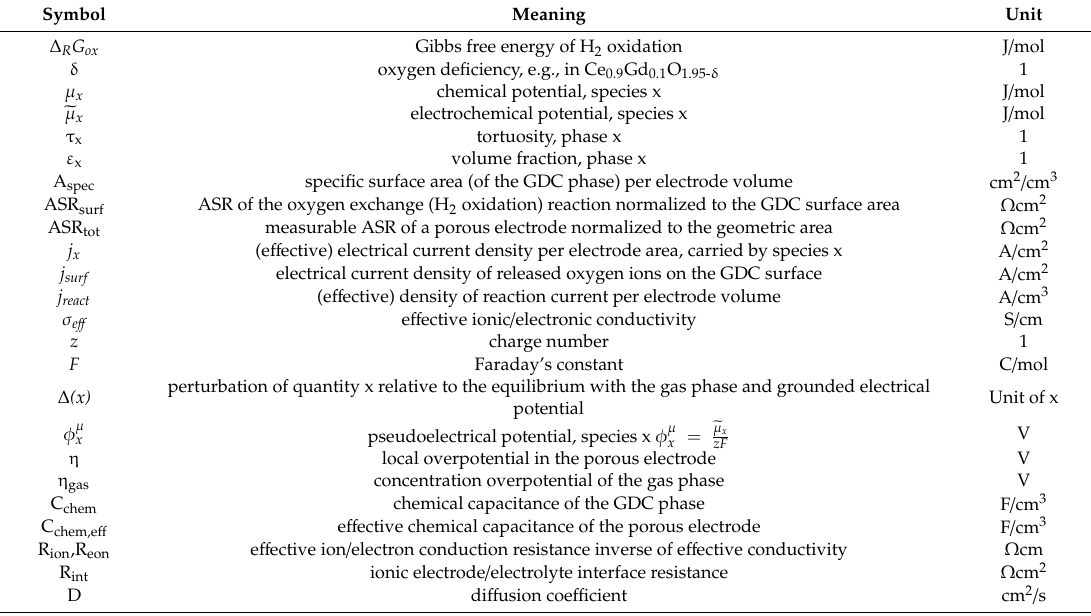
Table A2. List of used